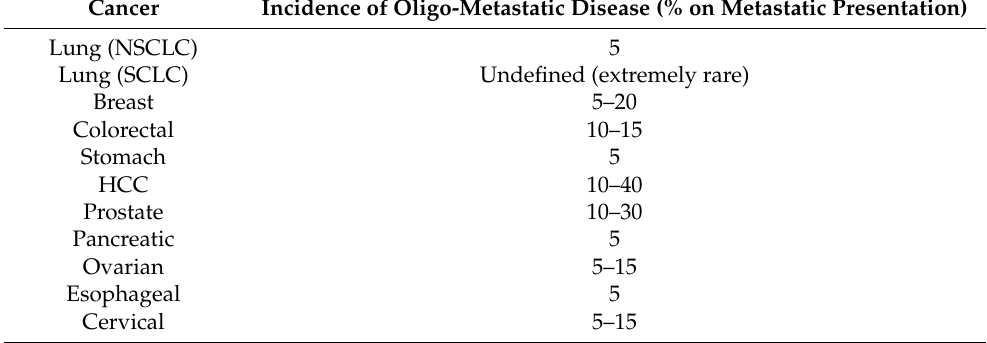
Table 1. Incidence of oligo-metastatic patients at diagnosis among metastatic patients in the ten most common